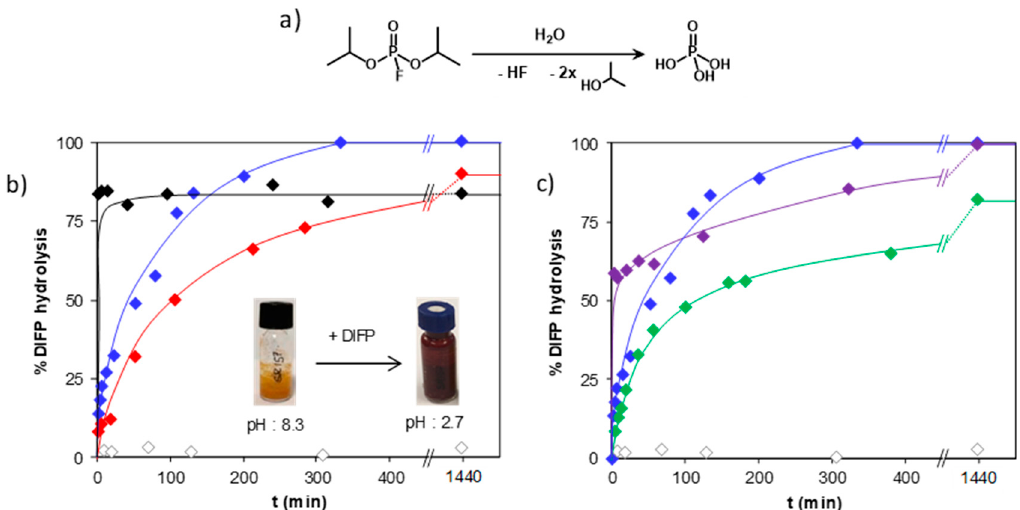
Figure 3. ( a ) Diisopropylfluorophosphate (DIFP) hydrolytic degradation reaction; ( b ) Reaction profiles for [HC ≡ C] 0.5 -TPB-DMTP-COF (black), [( S )-Py] 0.5 -TPB-DMTP-COF (red), and 1-step-[( S )-PyMe] 0.5 -TPB-DMTP-COF (blue) in unbuffered aqueous media. The inset in b shows the change of color exhibited by [HC ≡ C] 0.5 -TPB-DMTP-COF concomitant to solution acidification after DIFP degradation; ( c ) Reaction profiles for 1-step-[( S )-PyMe] 0.5 -TPB-DMTP-COF (blue), 2-step-[( S )-PyMe] 0.5 -TPB-DMTP-COF (purple), and amorphous [( S )-PyMe] 0.5 -TPB-DMTP-Polym